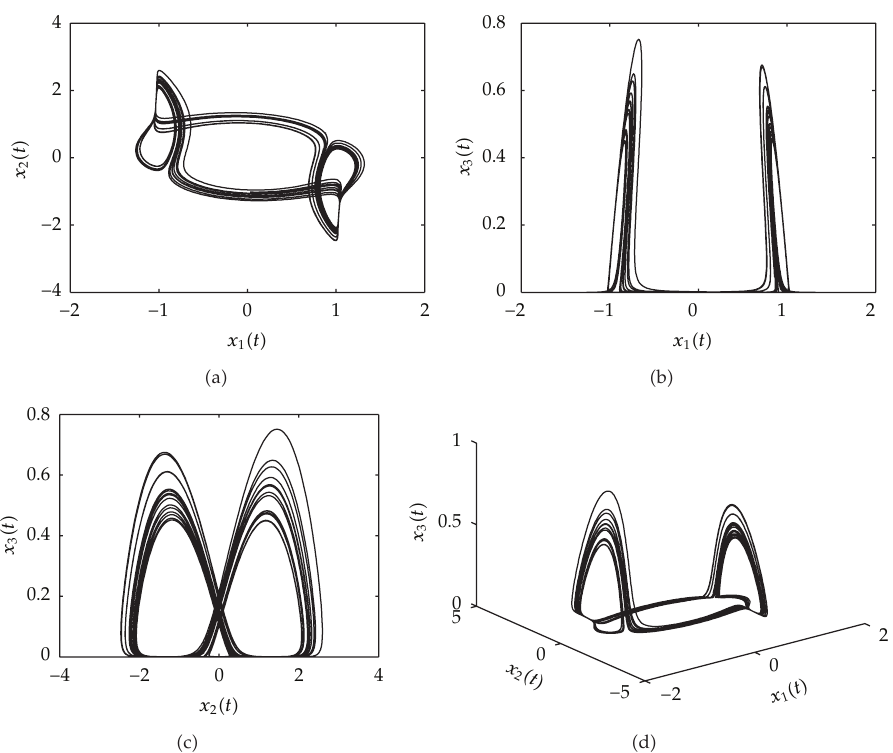
Figure 8: Phase plots for the Rabinovich-Fabrikant equations for a (cid:9) 0 . 1 and b (cid:9) 0 .